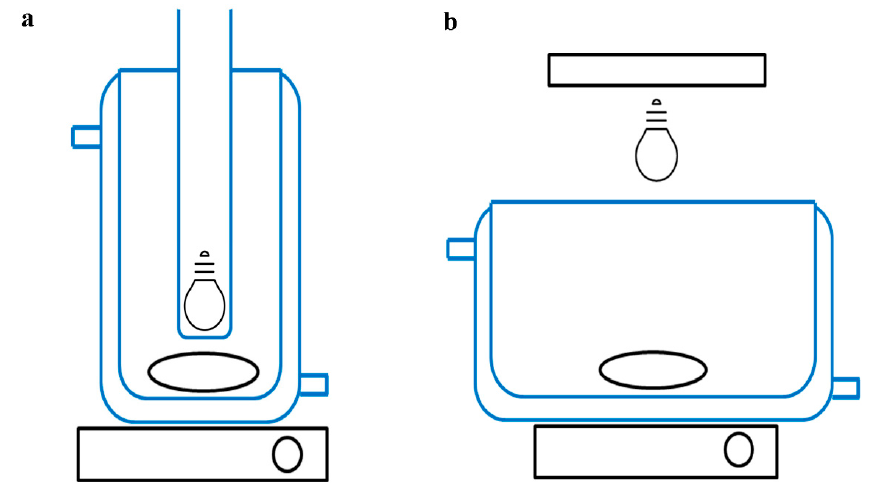
Figure 11. Reactor scheme ( a ) immersed lap (UV) and ( b ) external lamps (UV and